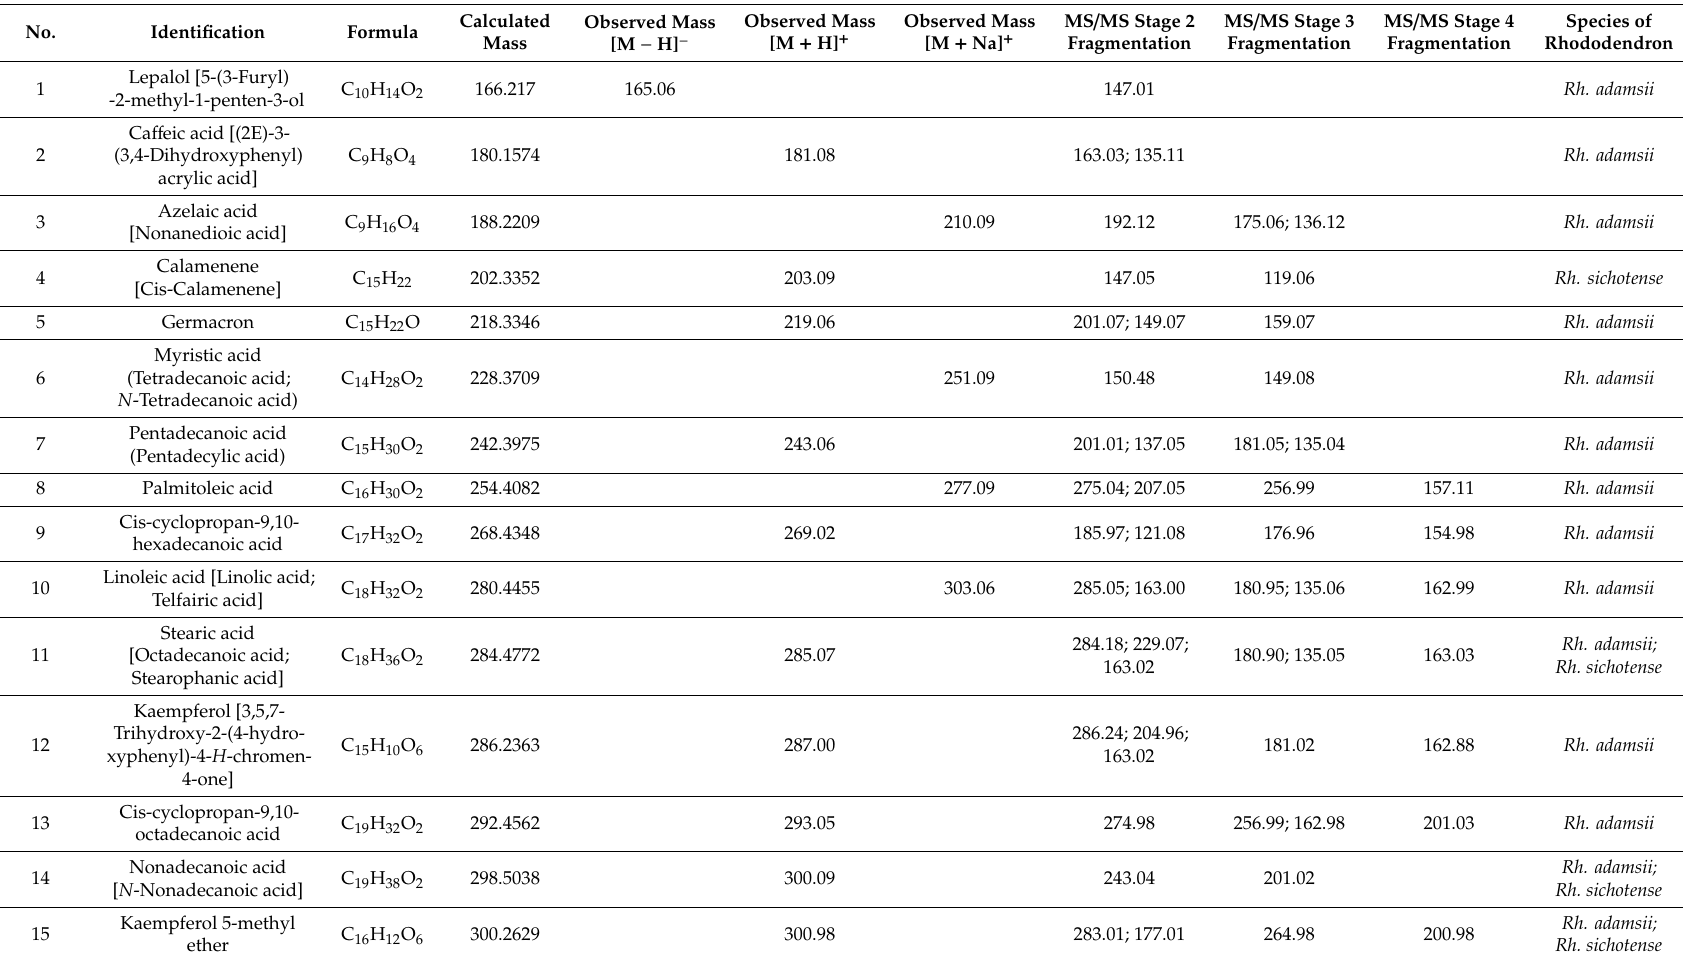
Table 4. Components identified from the SC-CO 2 extracts of Rh. sichotense and Rh. adamsii